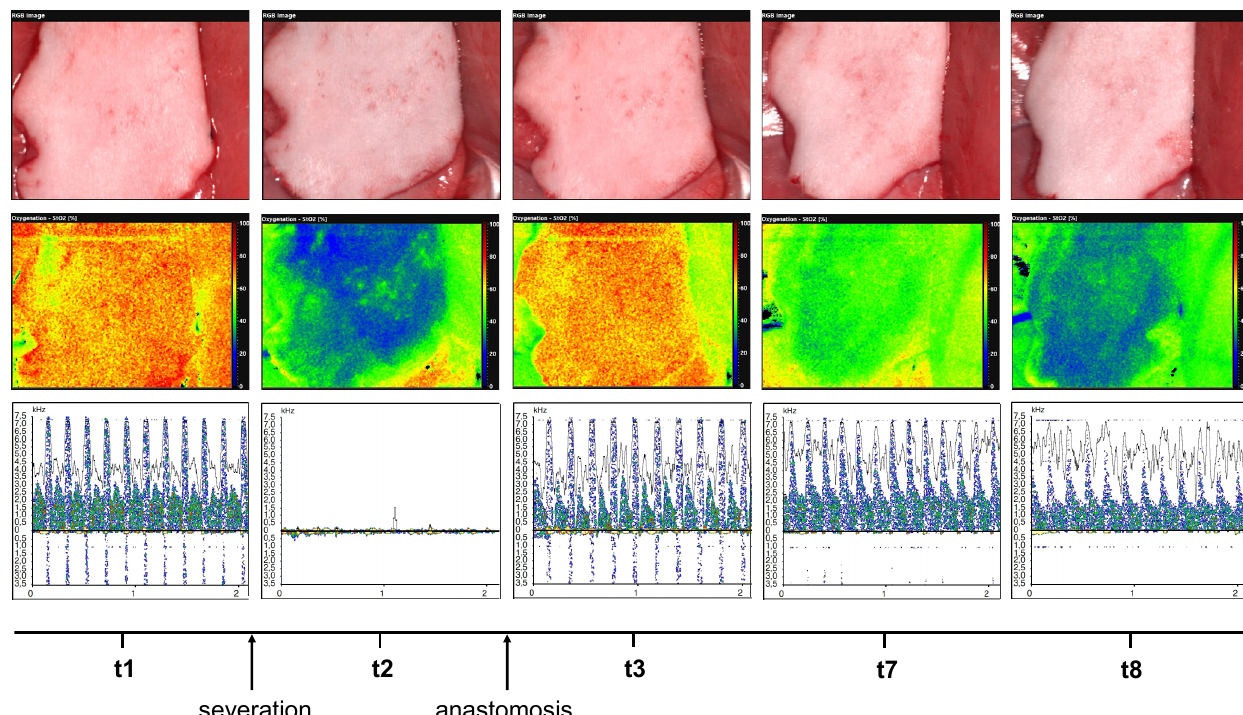
asterisk indicates onset of significant decreases in StO 2 and NPI at t7. The dashed lines indicate the parameter value level at t3.